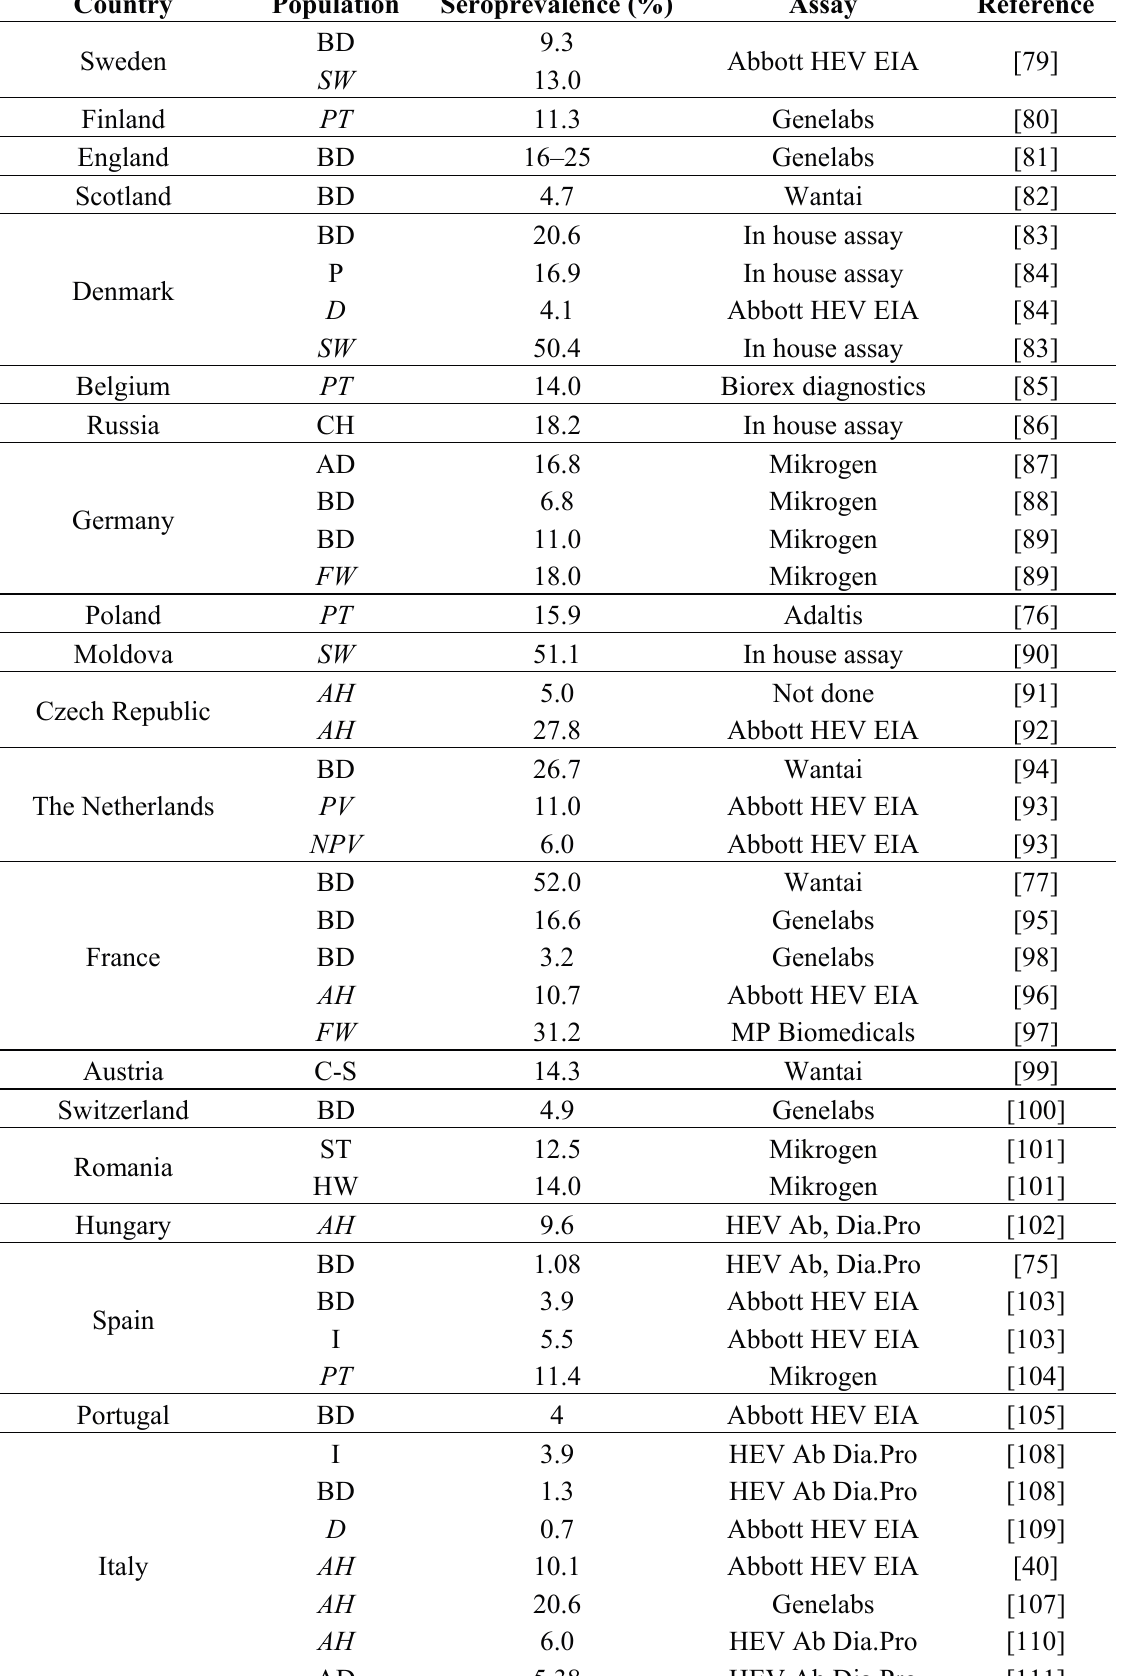
Table 1. Hepatitis E seroprevalence in general populations and risk groups in European countries. Country